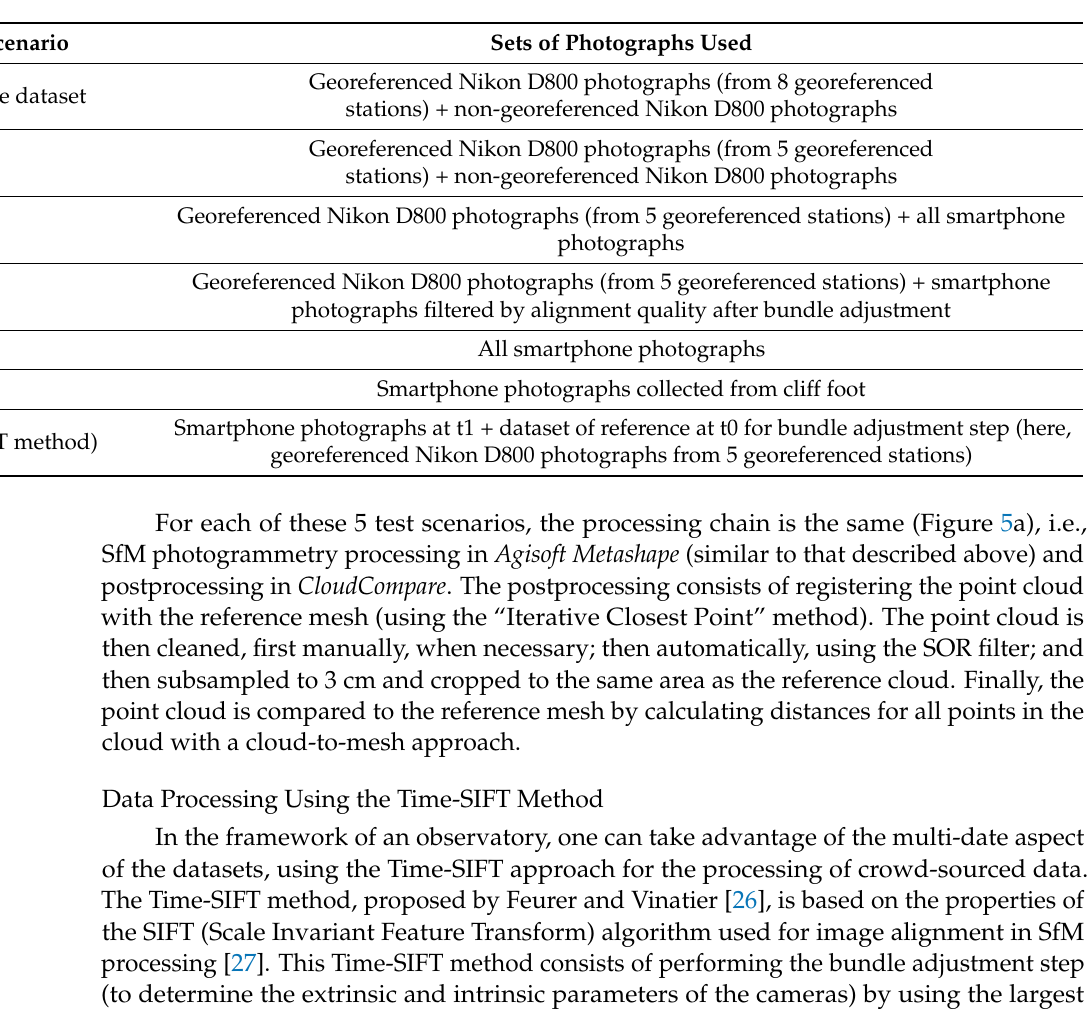
Table 2. Sets of photographs used in each processing